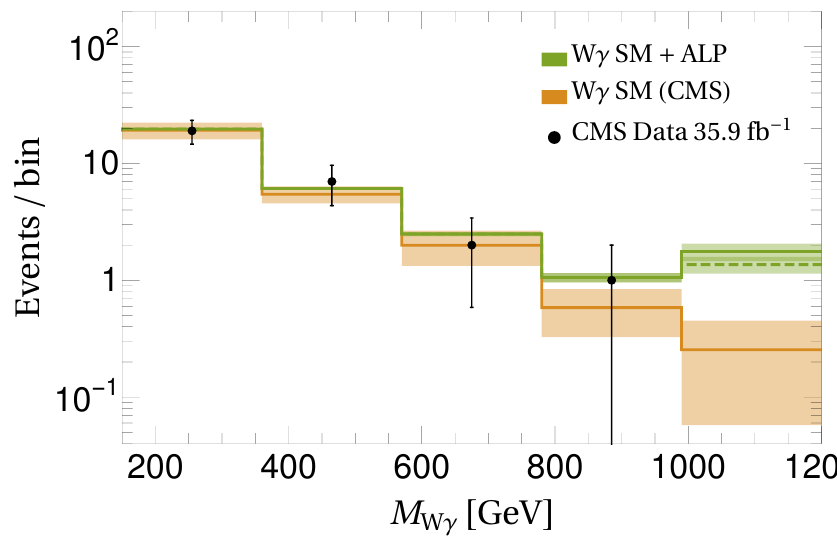
Figure 9 . M Wγ distribution for the pp → jjW ± γ → jjγ‘ ± ν channel.The data points and the total SM background (orange) are taken from the measurement in ref. [52]. The last bin contains the overflow events. The dashed and solid green lines show the total ALP EW VBS signal for c /f a = c /f a = 1 TeV − 1 with a cut of M Wγ < 2 TeV and 4 TeV , e B e W